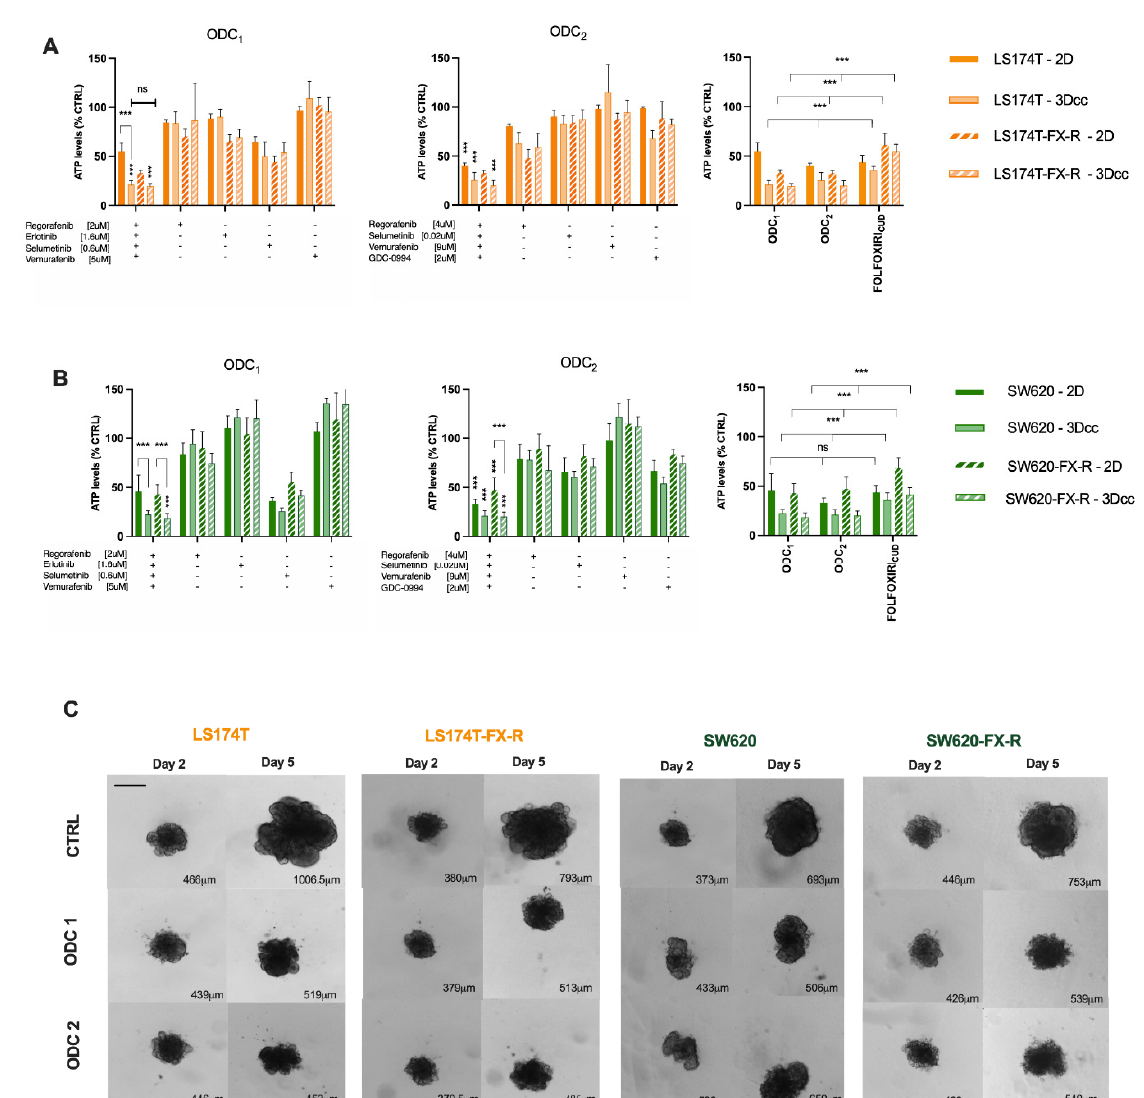
Figure 7. Activity of ODCs in 2D and 3D co-cultures of LS174T ( A ) and SW620 ( B ) FX-naïve and FX-R cells. Error bars represent the SD and significances of *** p < 0.001 (two-way ANOVA with post hoc Tukey’s and Sidak’s multiple comparisons test) N = 3, n = 3. (C) Representative bright field images of 3D co-cultures on day 2 and day 5 of experiment in control-(CTRL-) and ODC-treated conditions. Scale bar represents 400 μ m. Quantification analysis was performed using imageJ (0.0783 pixels/ μ m). The numbers in the bottom right corner correspond to average diameter of each spheroid.